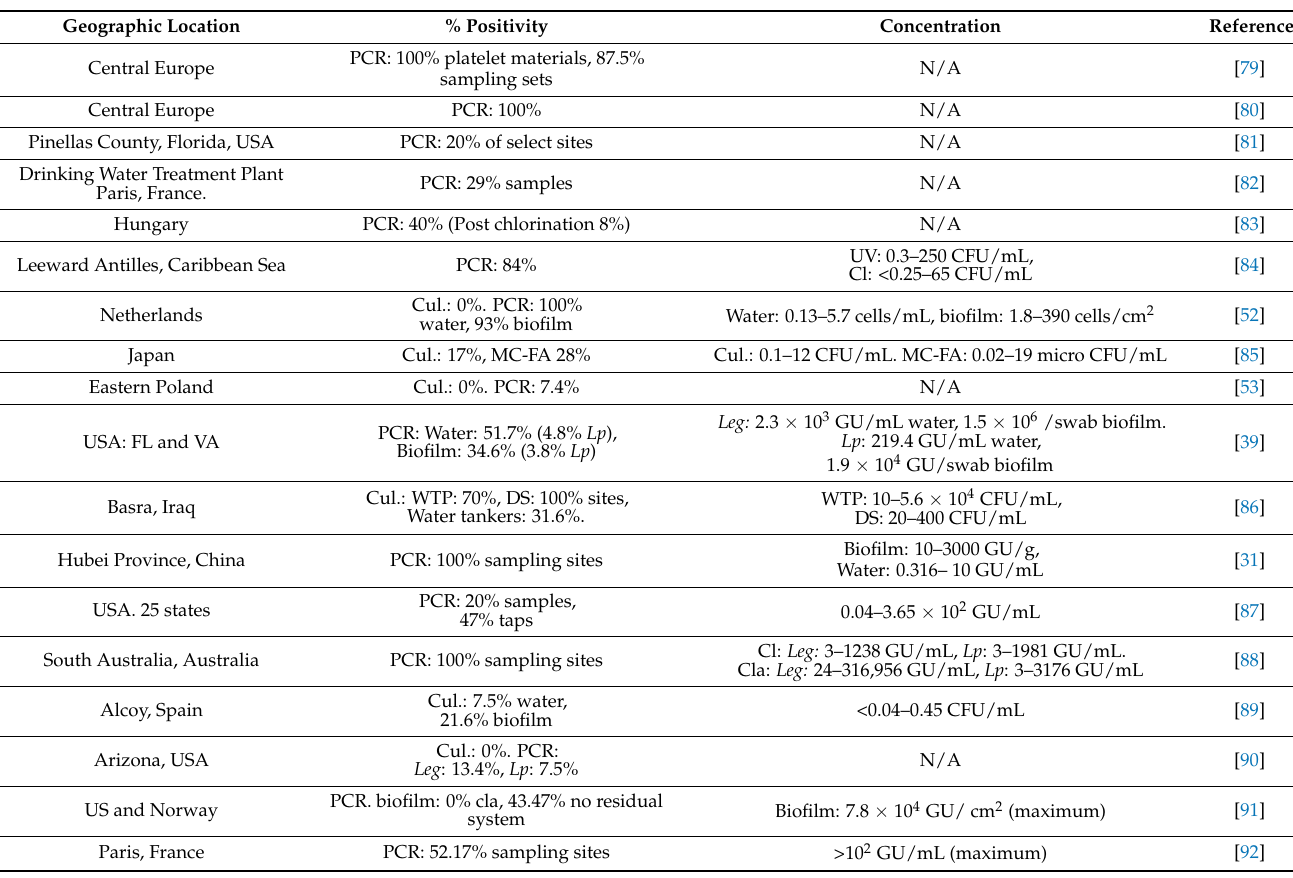
Table 4. Occurrence of Legionella in Distribution System Drinking